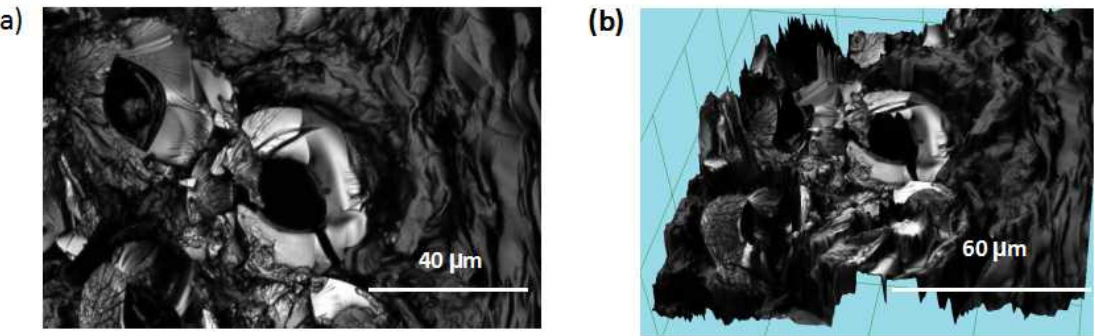
Figure 1. Optical microscopy image of the original composite: Hollow pitch fibers/Paraffin composite ( a ), the three-dimensional stereogram of Hollow pitch fibers/Paraffin composite ( b ).